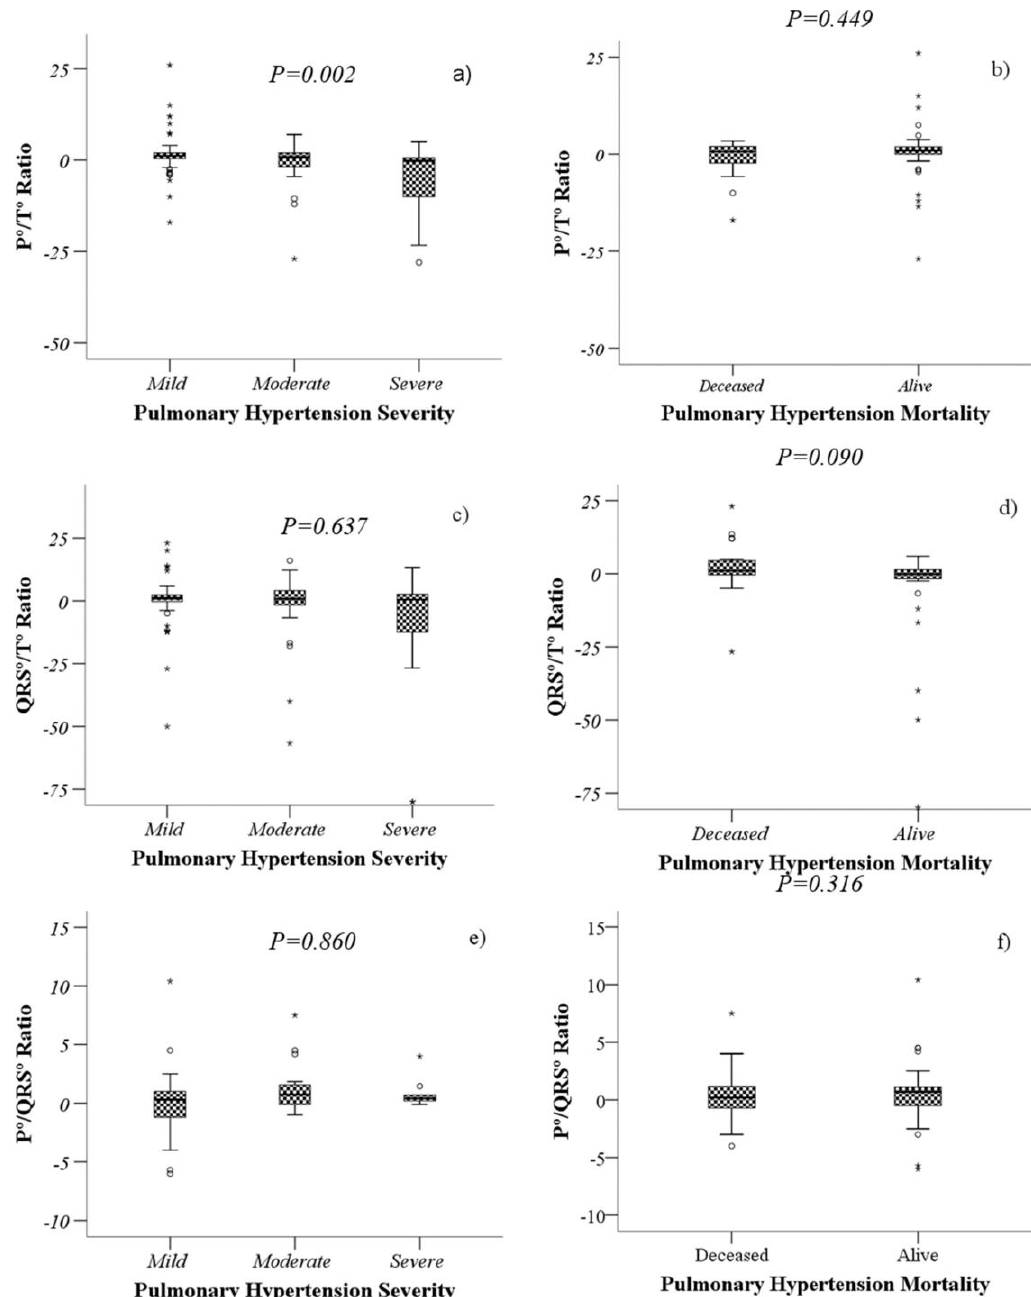
Figure 1. Comparison of the values of P°/T° ratio, QRS°/T° ratio and P°/QRS° ratio according to severity ( a , c , e ) and mortality ( b , d , f ) of patients with PH. Boxplots represents the medians and interquartile ranges 25–75. The Kruskal–Wallis test ( a , c , e ) and the Mann – Whitney U test ( b , d,f ) were performed, as appropriate. A lower P°/T° ratio was associated with severe PH ( p = 0.007), while a higher QRS°/T° ratio was associated with higher mortality ( p = 0.038). The P°/QRS° ratio did not show statistical significance with either mortality or severity (Figure 2).